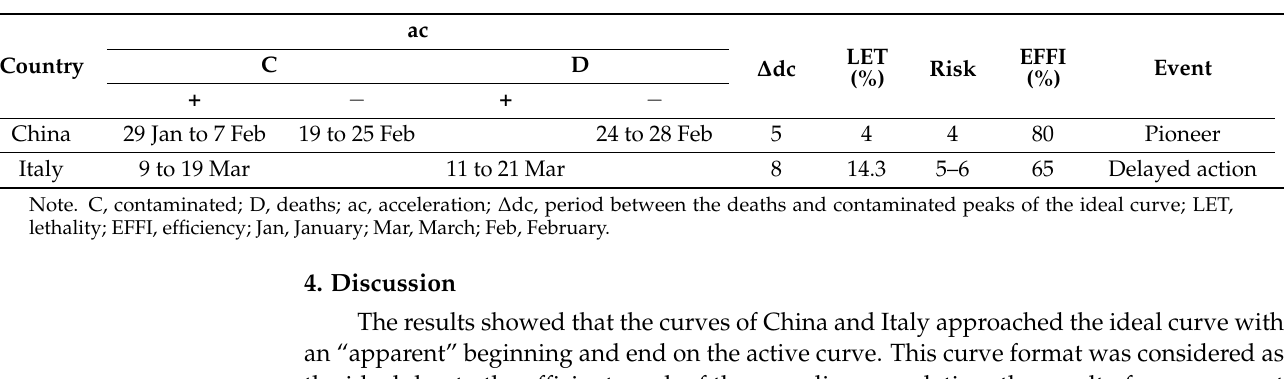
Table 4. Results of the parameters. Part